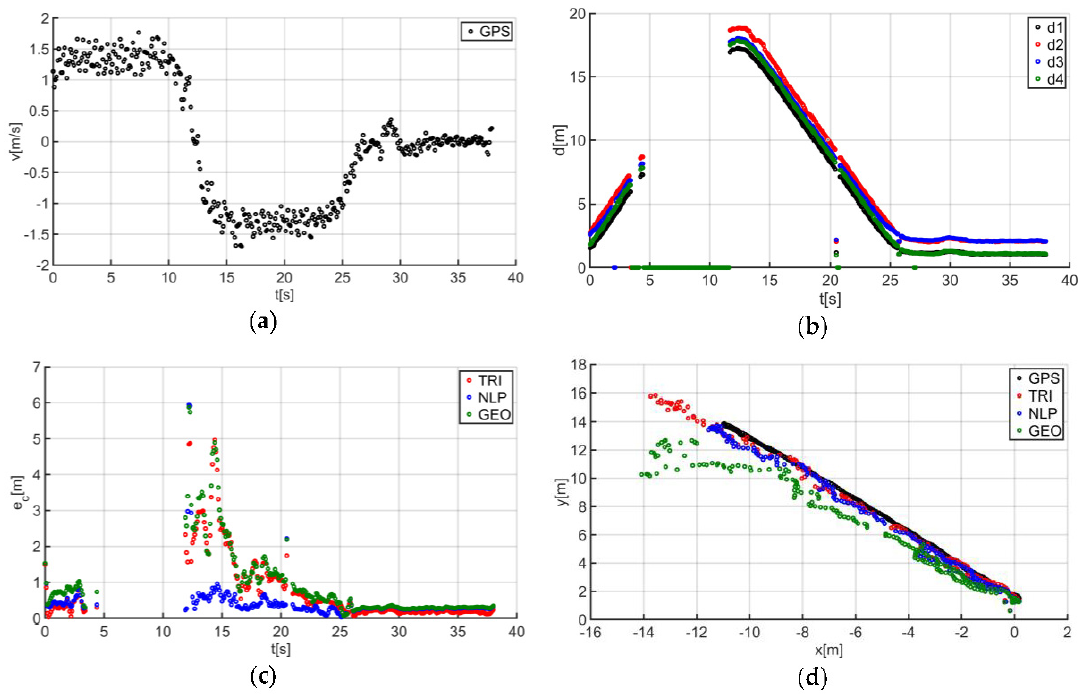
Figure 16. Test results no. 3: ( a ) human guide speed v p (t) and ( b ) filtered distance from anchors d i (t), i = 1, 2, 3, 4; ( c ) course of total location errors e c (t) and ( d ) location of the human guide y p (t) = f(x p (t)).